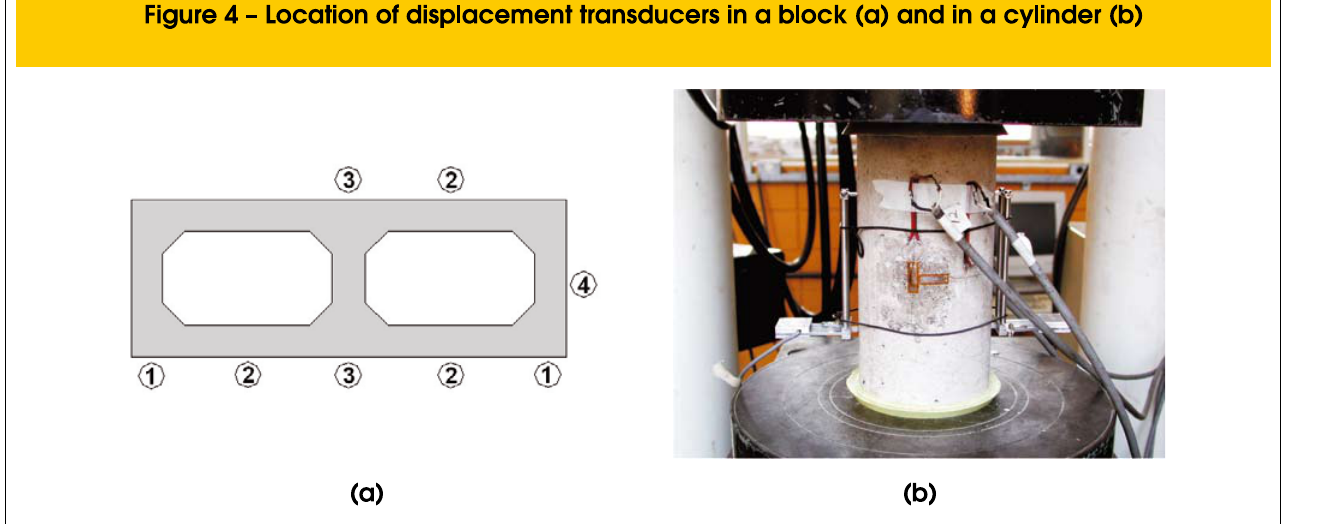
ed in Figure 3b. For example, reference line 2 locates a transducer that is disposed on the main face of the block, in the middle of the hollow. The strain measurement in cylindrical concrete samples was performed by two displacement